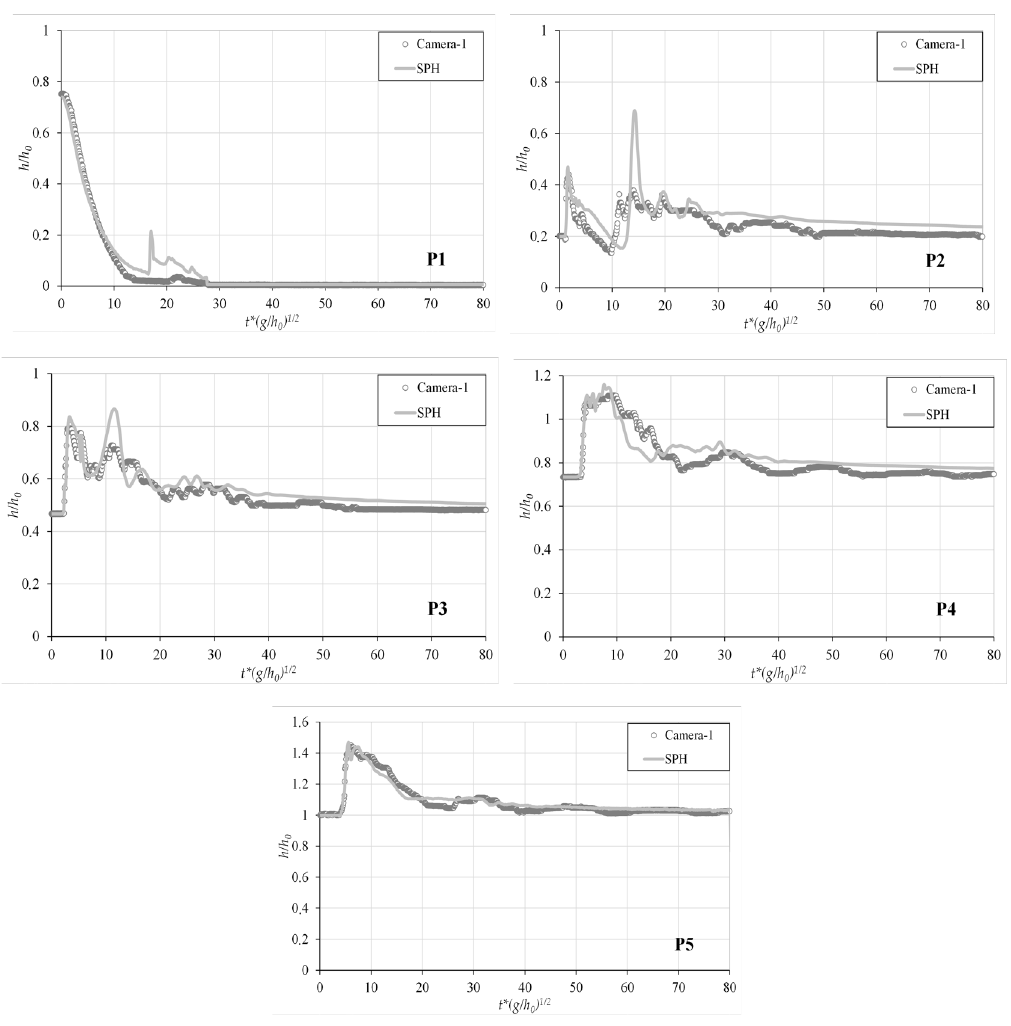
Figure 12. Visual comparison of the overtopping and the reflected wave due to the downstream dam ( a ) experiment ( b ) SPH.